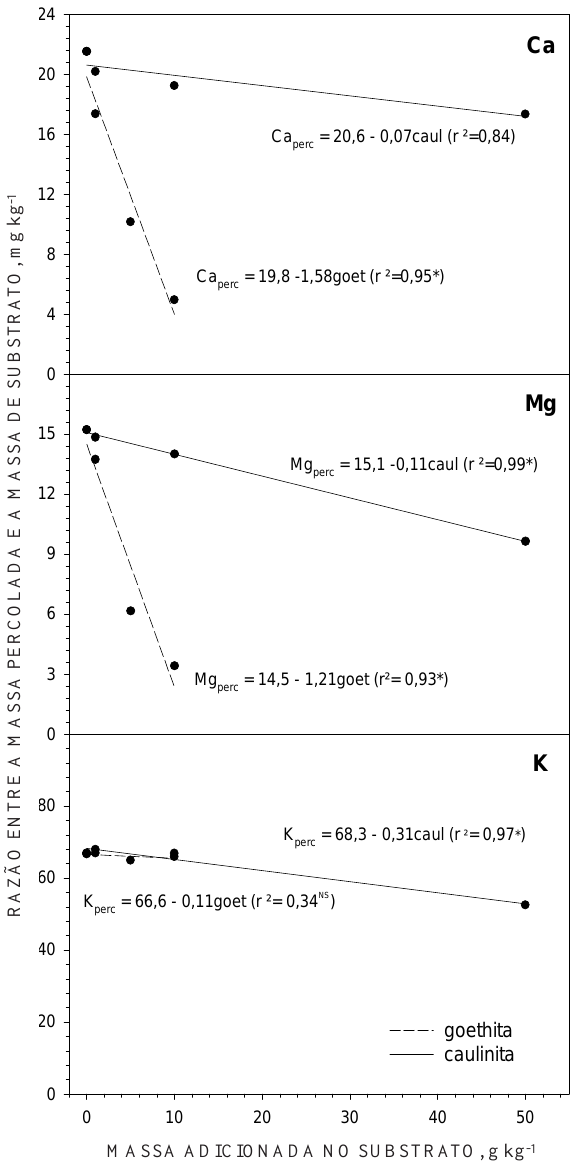
Figura 2. Razão entre as massas percoladas (perc) acumuladas de Ca, Mg e K, após 113 dias de decomposição de palha de milho, considerando a massa adicionada de goethita sintética (goet) ou caulinita natural (caul) em substratos inorgânicos (* P < 0,05 e NS